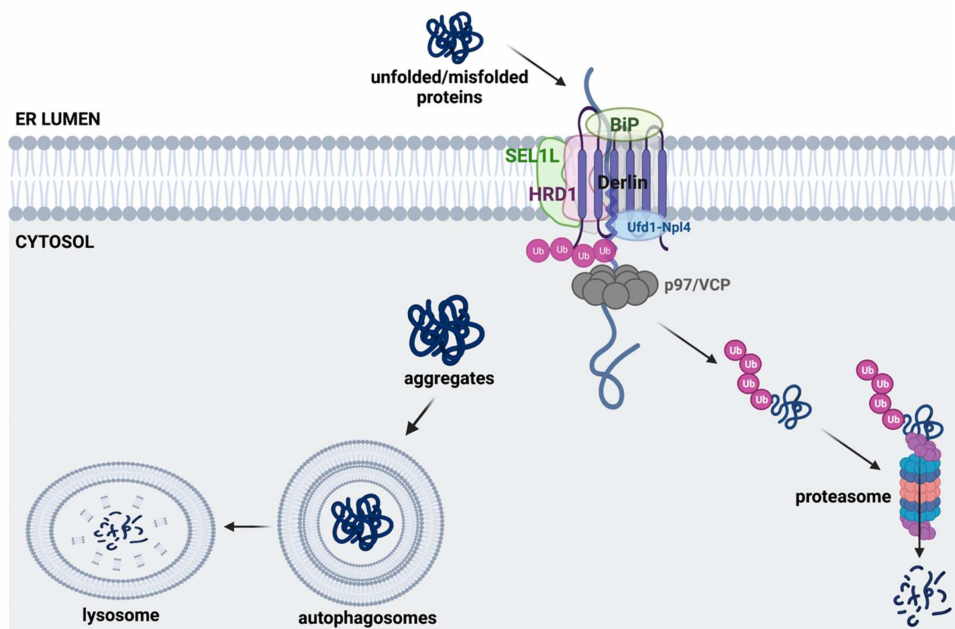
Figure 2. Misfolded protein clearance by autophagy and ERAD. For ERAD, unfolded/misfolded proteins are retrotranslocated to the cytosol through retrotranslocons such as Derlin and Hrd1, and ubiquitinated by E3 ligase (e.g., Hrd1; Sel1 is a cofactor of Hrd1). Polyubiquitinated ERAD substrate proteins are recognized and degraded by 26S proteasome in the cytosol. Protein aggregates, macromolecules, and organelles are also cleared via the autophagy-lysosomal